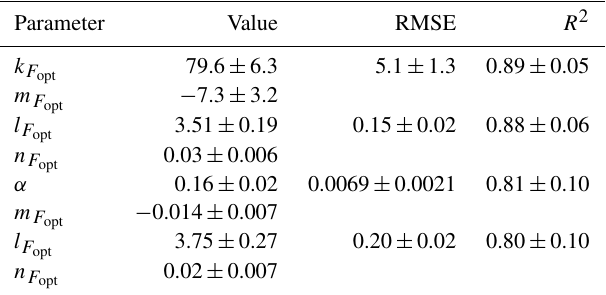
Table 7. The parameters for Eq. (13) that were used in the final gross primary production (GPP) model. RMSE is the root mean square error, and R 2 is the coefficient of determination for the re- gression models predicting the different